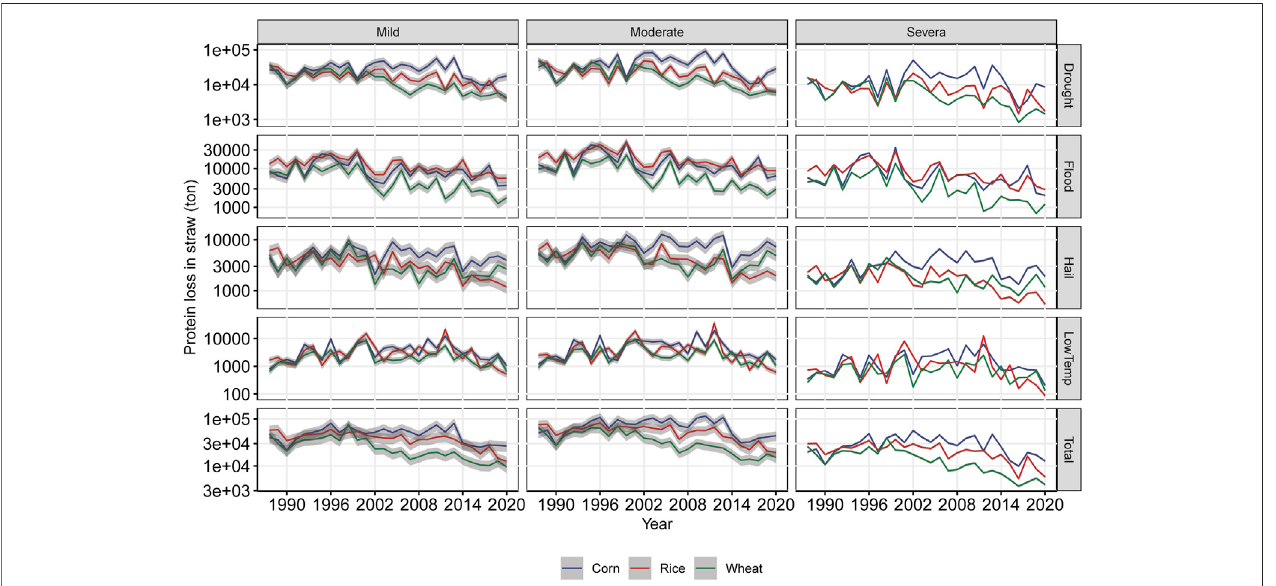
FIGURE 9 | Trends in protein loss from the straw harvest in maize, rice, and wheat due to different natural disasters from 1988 to 2020. The shaded regions represent one standard deviation of the protein loss in the straw.